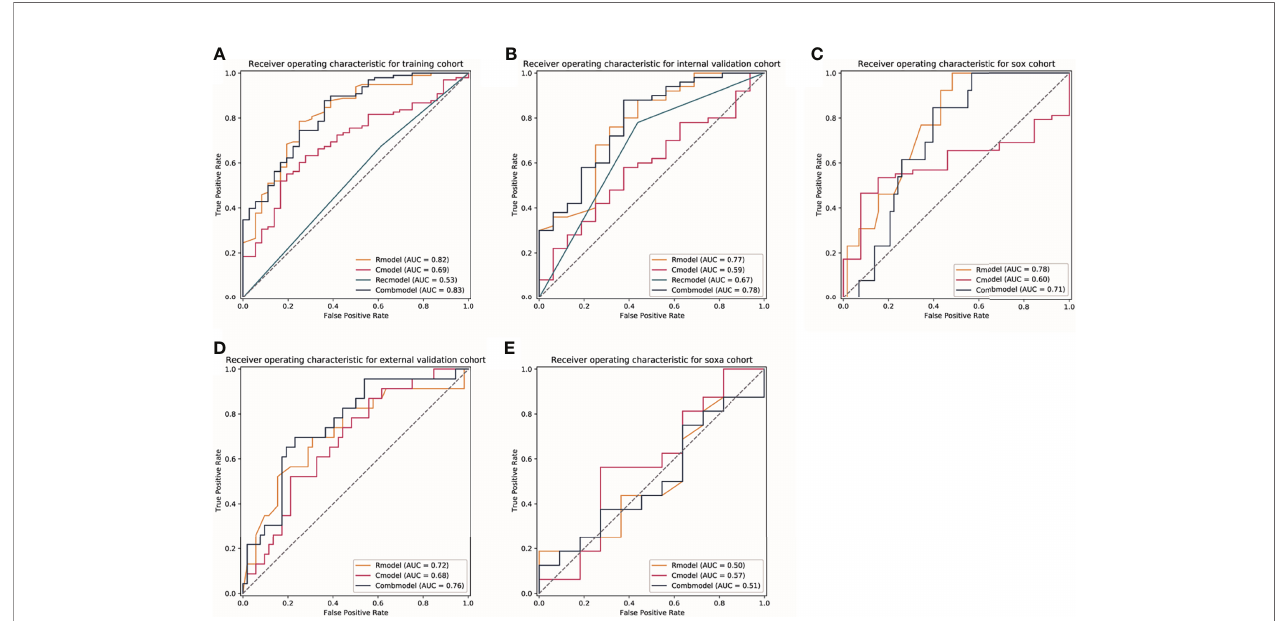
FIGURE 3 | The receiver operator characteristic (ROC) curves for models in each cohort. (A – E) Represents ROC curves of models for patients in the training cohort, the internal validation cohort, the Dragon III cohort, the external validation cohort, and the SOXA cohort. Rmodel, the radiomics model; Cmodel, the clinical model; Recmodel, the RECIST model; Combmodel, the combined model. The SOX cohort is de fi ned the patients receiving the regimen of S-1 and oxaliplatin; the SOXA cohort is de fi ned as the patients receiving the regimen of apatinib in combination with SOX (S-1 and oxaliplatin). AUC, area under the